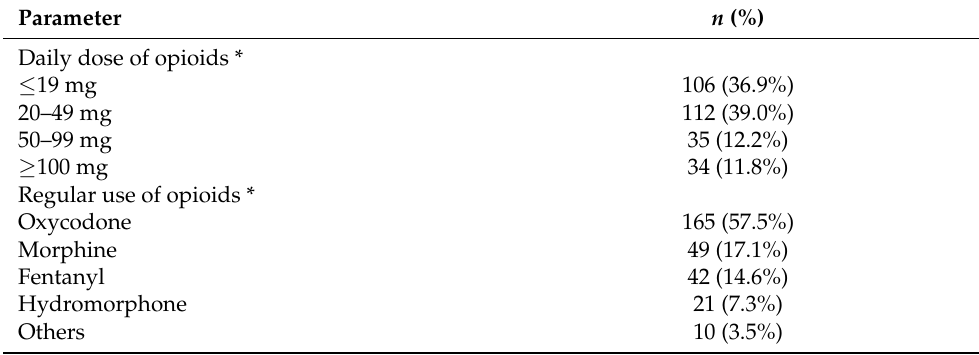
Table 2. Summary of opioid and laxative